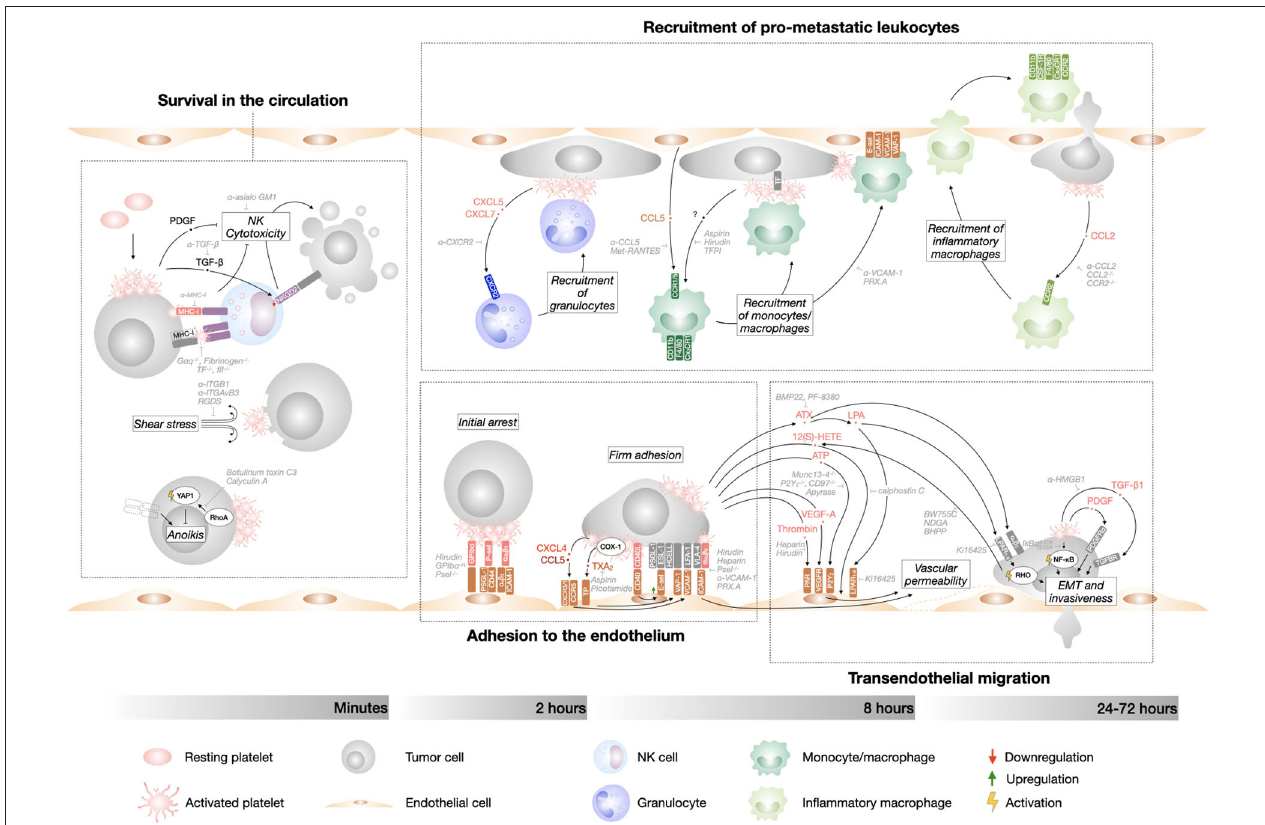
FIGURE 2 | Tumor cell-platelet interplay during the metastatic cascade. Diagram depicting the intravascular steps of the metastatic cascade that are supported by platelet interaction with tumor cells and their timeline. Therapeutic approaches that interfere with the different steps of tumor cells dissemination are indicated in gray.